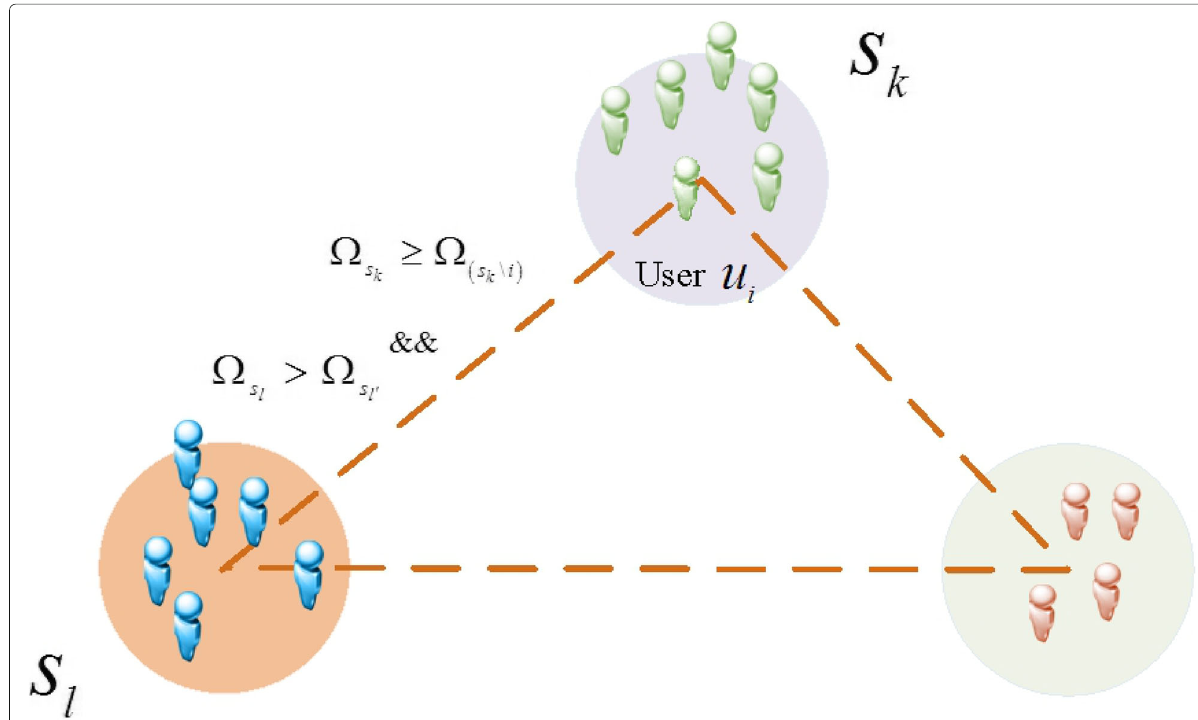
Fig. 2 The fog community graph after